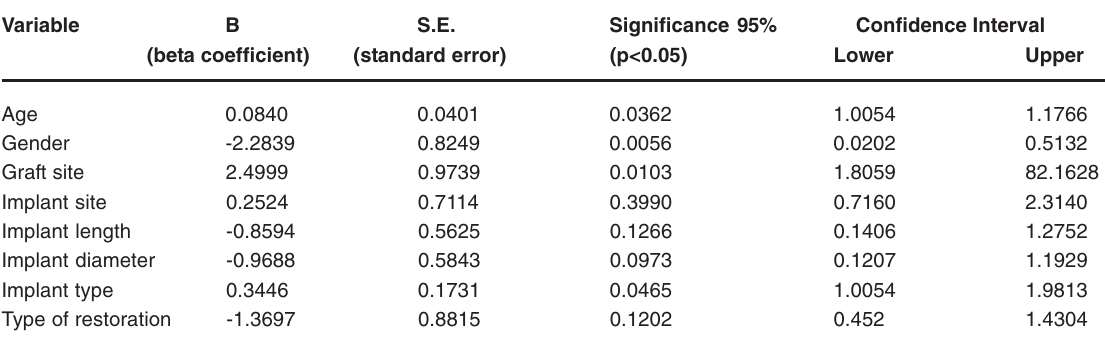
TABLE 3- Cox regression results showing the variables associated statistically with delta IAJ by evaluating delta